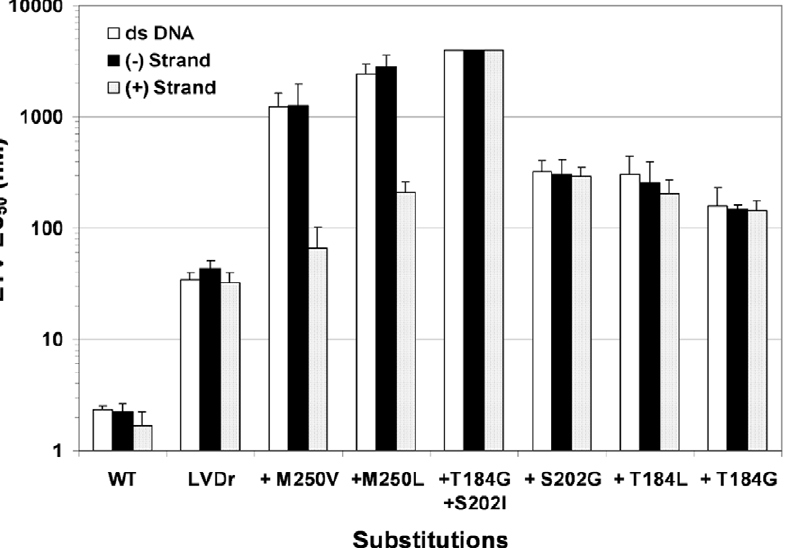
Figure 5. Analysis of ETVr through strand-specific DNA synthesis in culture. Cell culture ETV EC 50 determinations were made for wildtype and various resistant HBVs. The levels of HBV DNA synthesized in the presence of ETV was determined by HBV-specific probe hybridization to HBV nucleocapsid DNA from the cultures. The probes used were the typical double-stranded DNA probe, or strand-specific riboprobes which hybridized to a single HBV DNA strand. Comparison of strand-specific EC 50 versus double stranded EC 50 for wildtype polymerase (WT) or LVDr M204V + L180M HBV, or the LVDr substitutions with ETVr substitutions ( + T184, + S202, + M250) as indicated. Values at 4000 nM indicate that 50% inhibition was not observed at the highest ETV concentration